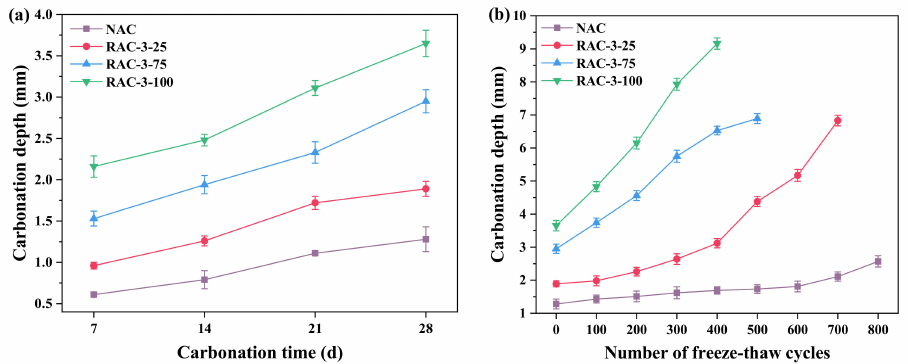
Figure 8. Carbonation depth of RAC-3 with different replacement rates ( a ) before and ( b ) after freeze–thaw